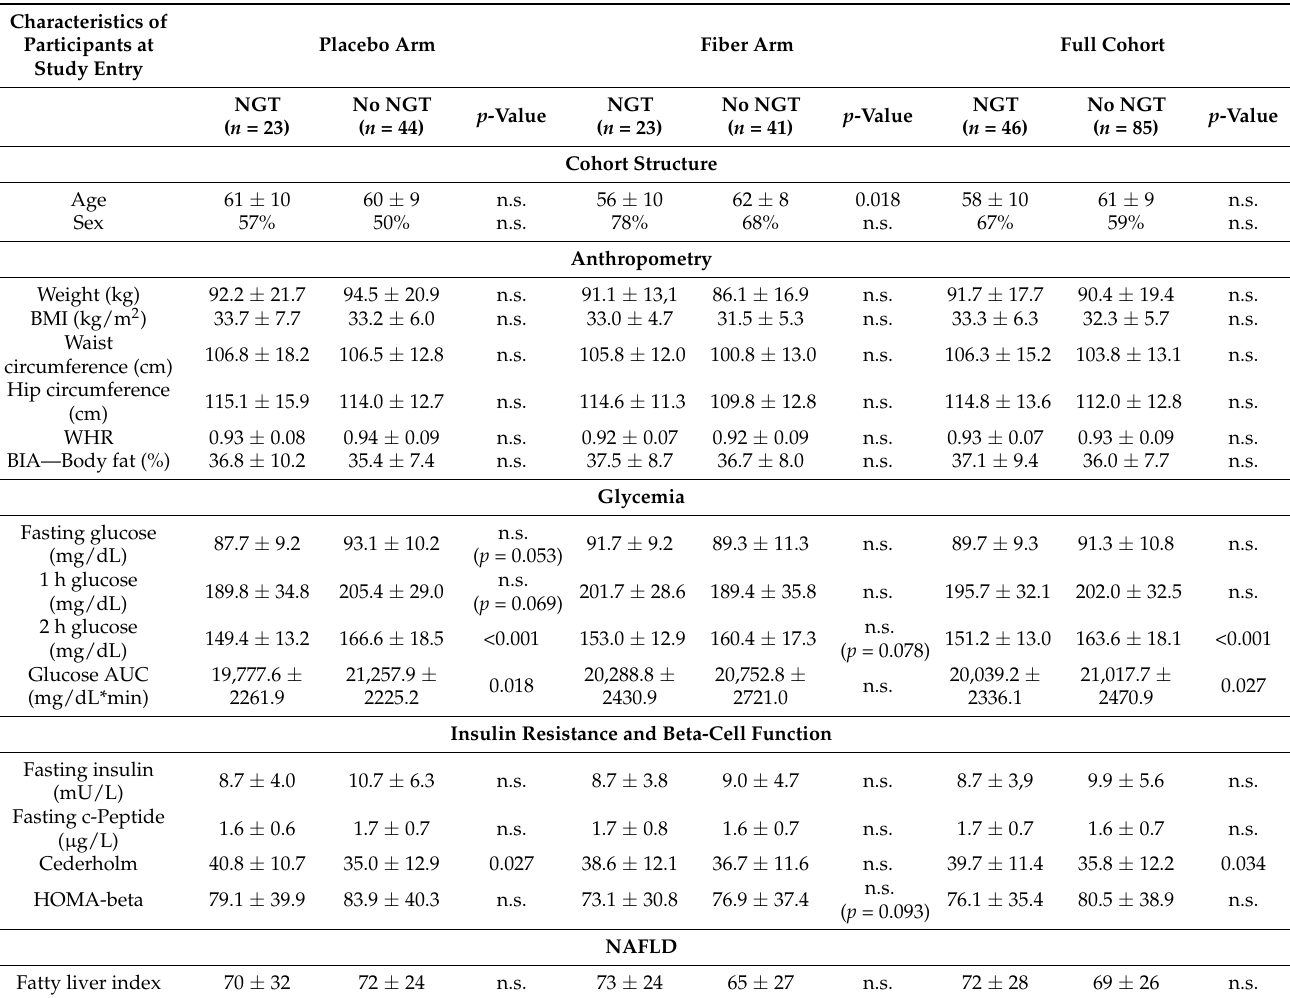
Table A1. Characteristics of responders and non-responders (NGT) at study entry; Mann–Whitney tests for comparison of NGT and non-NGT